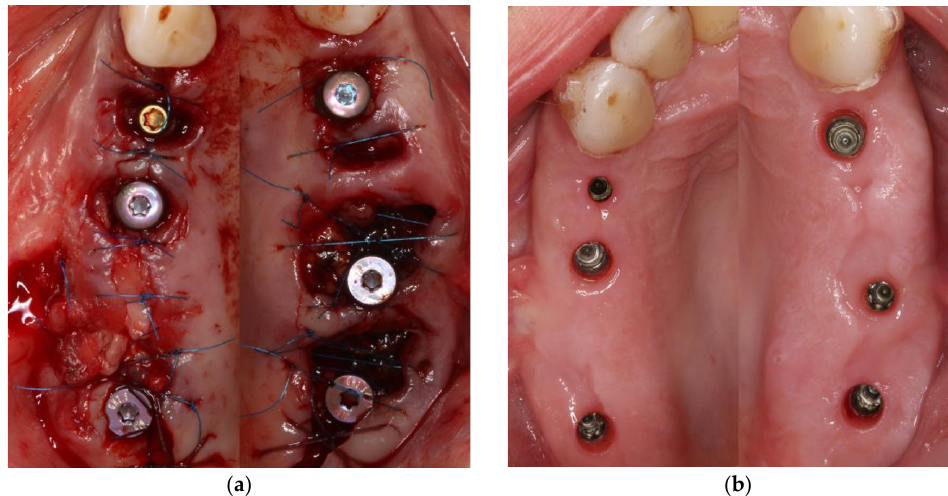
Figure 16. Intraoral pictures of the implants of teeth 14, 15, 17, 24, 26, and 27: ( a ) immediately after surgery; ( b ) 3 months after